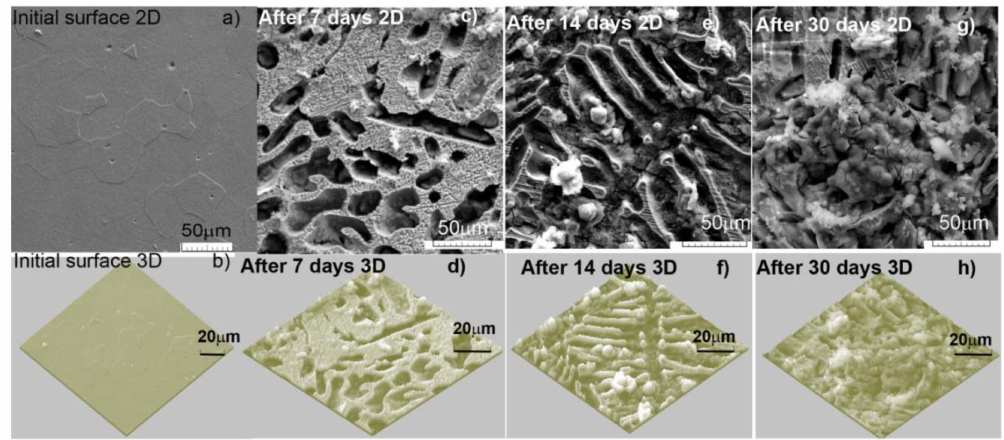
Figure 1. 2D and 3D structural aspects (the augmenting of the image of 1000 × ) of the surface of FeMnSi–MgCa alloy ( a , b ) initial surface, ( c , d ) the surface after seven days, ( e , f ) the surface after 14 days, and ( g , h ) the surface after 30